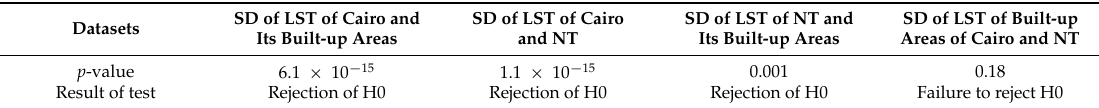
Table 5. Results of Mann–Whitney U-test on the datasets of SD of LST.